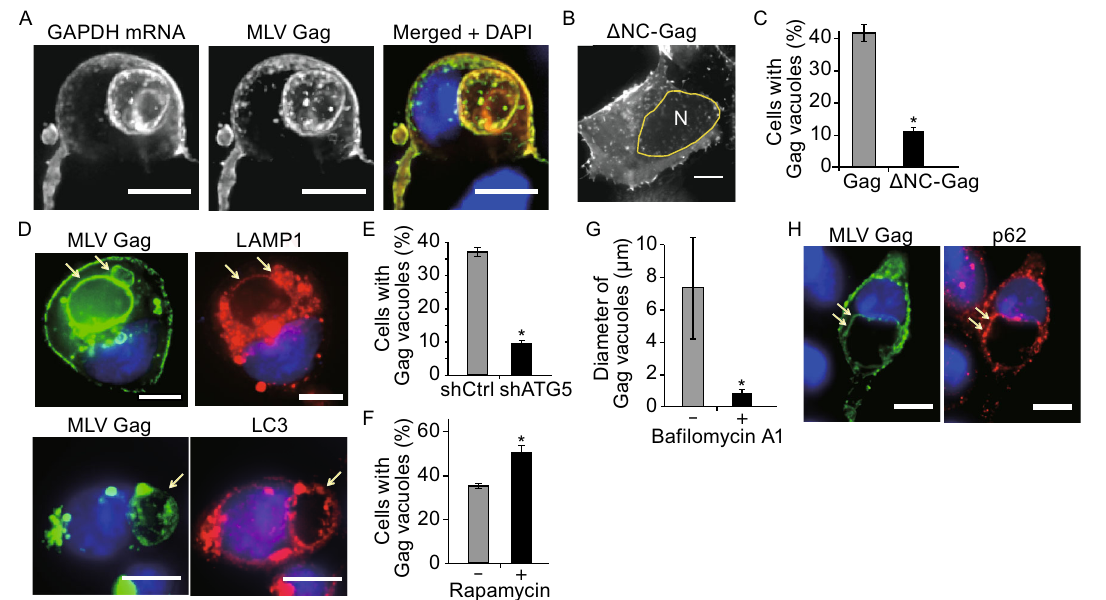
Figure 5. The effect of RNA-Gag interactions and autophagy on lysosomal delivery of misassembled MLV Gag complexes. (A) Representative images of GAPDH mRNA, detected by FISH, and Gag, detected by Gag-EGFP, in MiR + cells transfected with MLV Gag-EGFP. (B) Representative image of MLV- Δ NC-Gag, detected by MLV Δ NC-Gag-EGFP in MiR + cells. N indicates nucleus. (C) Percentage of MiR + cells with large (diameter > 1 μ m) intracellular vacuoles at 48 h post-transfection of MLV Gag or MLV Δ NC-Gag. (D)RepresentativeimagesofLC3andLAMP1,detectedbyimmuno fl uorescence,inMiR + cellsexpressingMLVGag-EGFP.Arrowspointto the vacuoles. (E) Knockdown of ATG5 led to a reduction in Gag vacuole formation. (F) Treatment with rapamycin (200 nmol/L) led to increased Gag vacuole formation. (G) Decrease in Gag vacuole diameter in response to ba fi lomycin A1 treatment. (H) Representative imagesofp62andMLVGaginMiR + cells.p62andMLVGagcolocalizeatthevacuoles.Arrowspointtothevacuoles.For(C),(E),and(F), data represent mean ± SD of three replicates, with each replicative experiment performed by visually examining at least 200 transfected cells. For (G), data represent mean diameter ± SD of at least 200 individual vacuoles. Scale bar = 10 μ